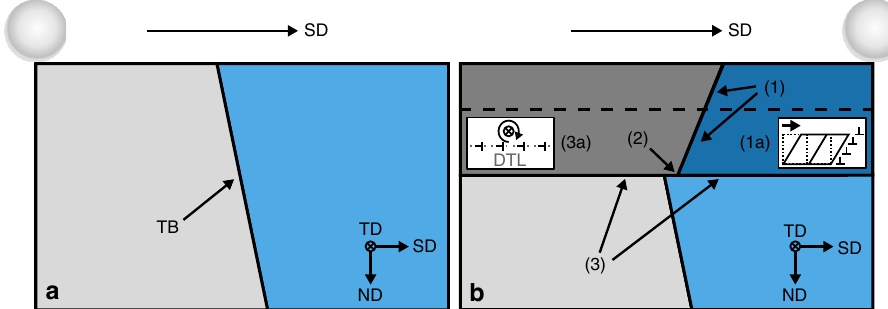
Fig. 3 Model concept of key features and associated elementary processes occurring in the vicinity of the twin boundary (TB) during tribological loading. a Initial microstructure prior to tribological loading. In this state, the TB is assumed to possess a straight line shape all the way up to the sample surface (cf. Supplementary Fig. 4). b Simpli fi ed schematic of altered microstructure after passing of sphere including key features and governing processes. Microstructural changes at upper DTL (dashed line) are omitted for clarity. (1) The tilting of the TB segment observed above the lower DTL is attributed to a simple shear of the subsurface area, con fi ned by the lower DTL. Inset (1a) visualizes the simple shear process and the character of edge dislocations involved. (2) A localized plastic shear process at the lower DTL is visible as step in sliding direction (SD). The TB may be regarded as a marker revealing both shear processes. (3) The lower DTL (horizontal line) accommodates a misorientation due to crystal lattice rotation of the whole volume above the DTL, depicted as a change in color. Inset (3a) visualizes the crystal rotation around an axis close to TD above the DTL and the character of exemplary edge dislocations accommodating the misorientation at the